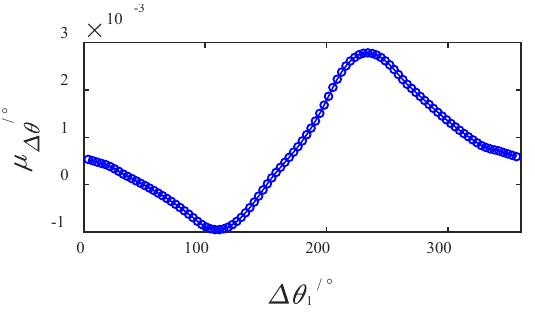
Figure 18. Mean value of rod 4 angle Figure 18 . Mean value of rod 4 angle error.